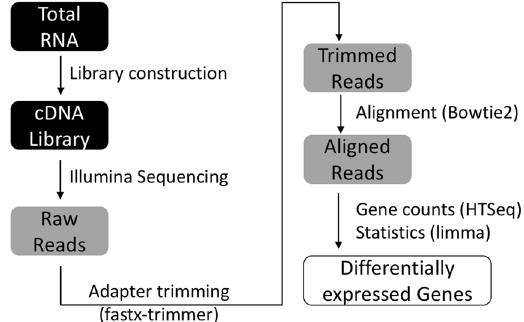
Figure 1. Bioinformatics work flow. Total RNA was isolated, and libraries were constructed and sequenced. Raw reads were filtered for quality and sequence contaminants and aligned to the reference genome of S. liquefaciens strain ATCC 27592 to calculate differential expression levels.